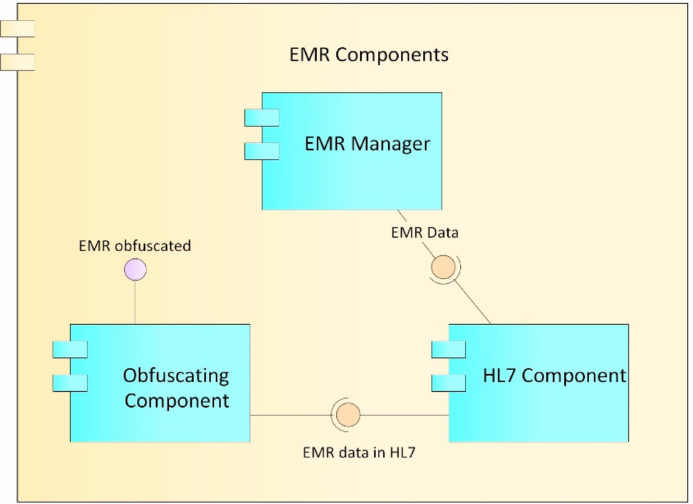
Figure 5. Electronic medical record (EMR)